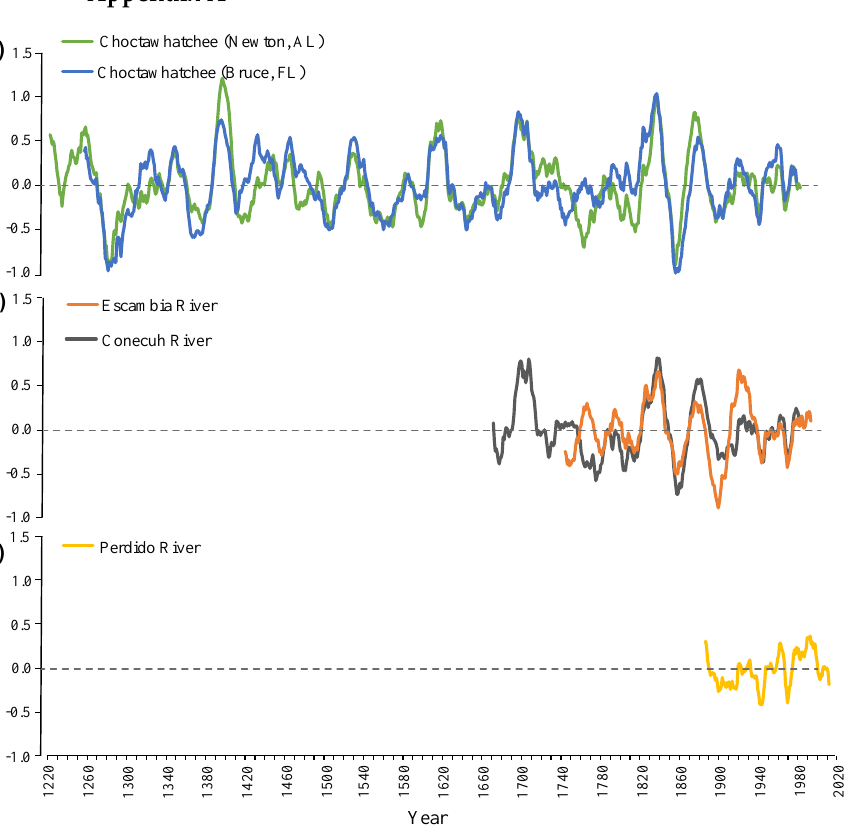
Figure A1. Comparison over the full reconstruction period of standardized streamflow reconstructions for the ( a ) Choctawhatchee River at gages in Newton, AL (1222–1985) and Bruce, FL (1257–1982), ( b ) Conecuh River (1671–1983) and Escambia River (1744–1993), and ( c ) Perdido River (1885–2011). All datasets have been smoothed with a 20-year-end-year running mean.